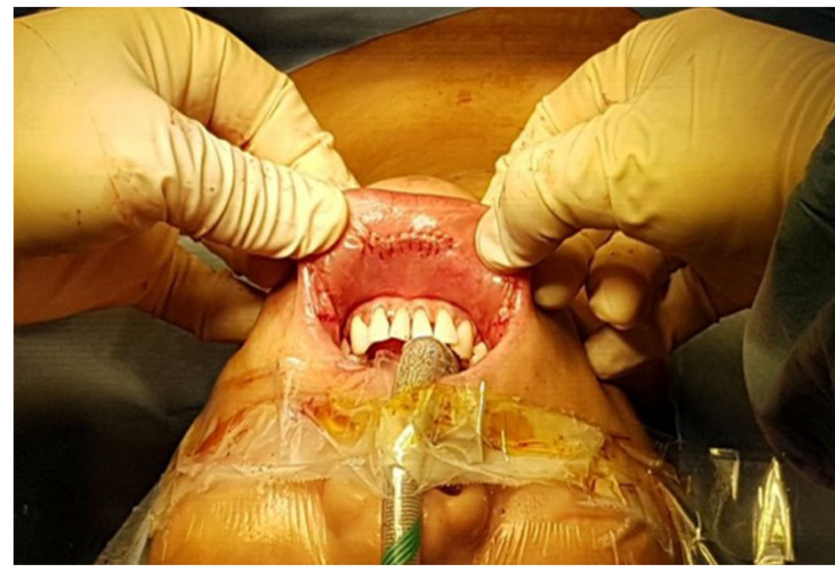
Figure 4. Oral mucosal incisions after